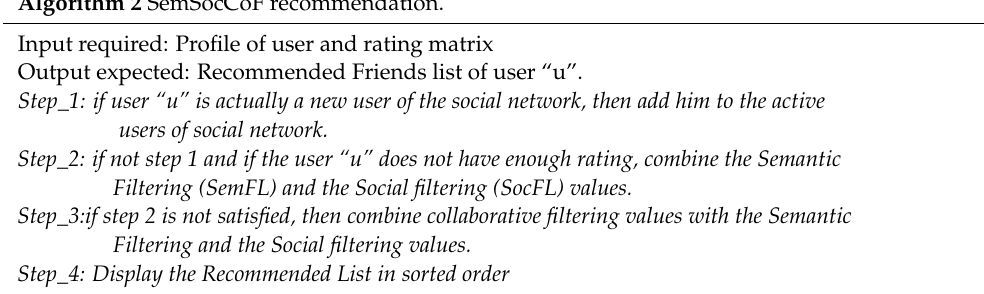
Algorithm 2 SemSocCoF